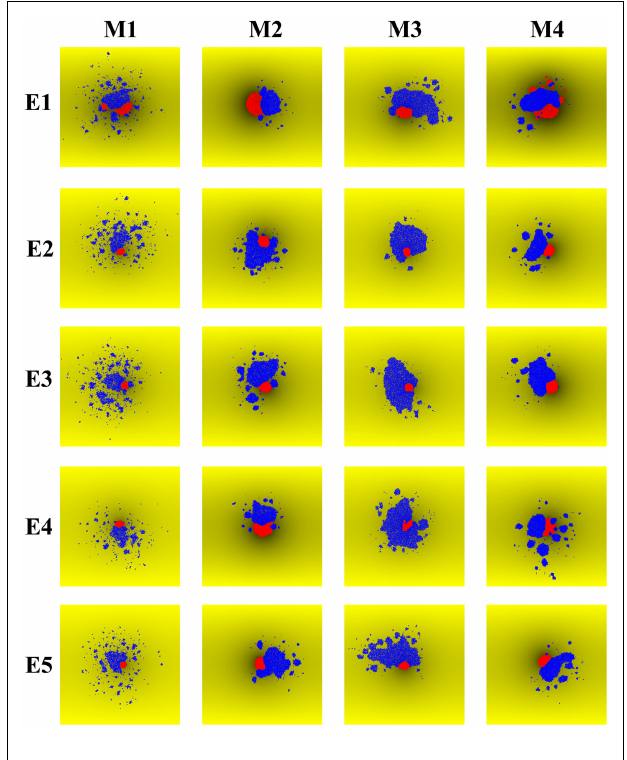
FIGURE 6 | Morphologies resulting from simulated competition between epithelial-like cells and mesenchymal-like cells in a growing avascular tumor. The tumors correspond to the same 20 simulations shown in Figure 5 , with five kinds of epithelial-like cells (E1–E5) and four kinds of mesenchymal-like cells (M1–M4) paired together. Epithelial-like (red) and mesenchymal-like (blue) cells usually grow as separate lumps. However, mesenchymal cells are more mobile and often surround the epithelial cells to starve them of space and nutrients, further slowing the growth of epithelial-like